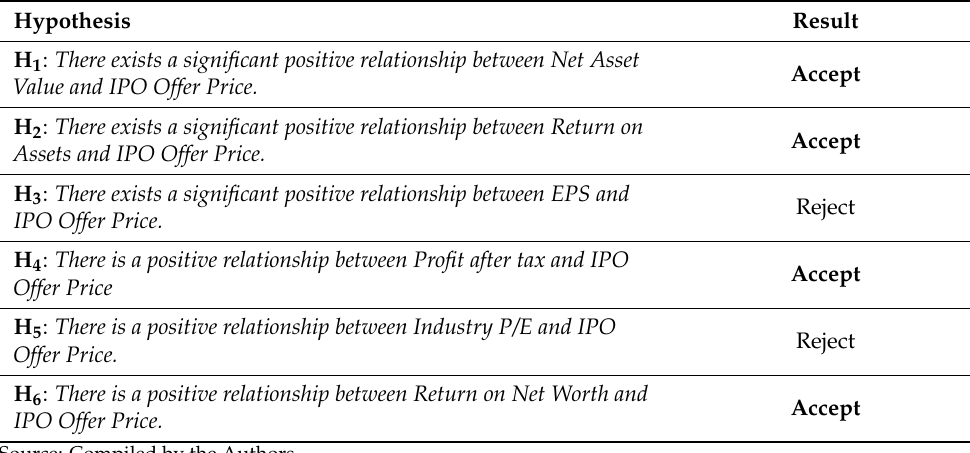
Table 9. Summary of Empirical